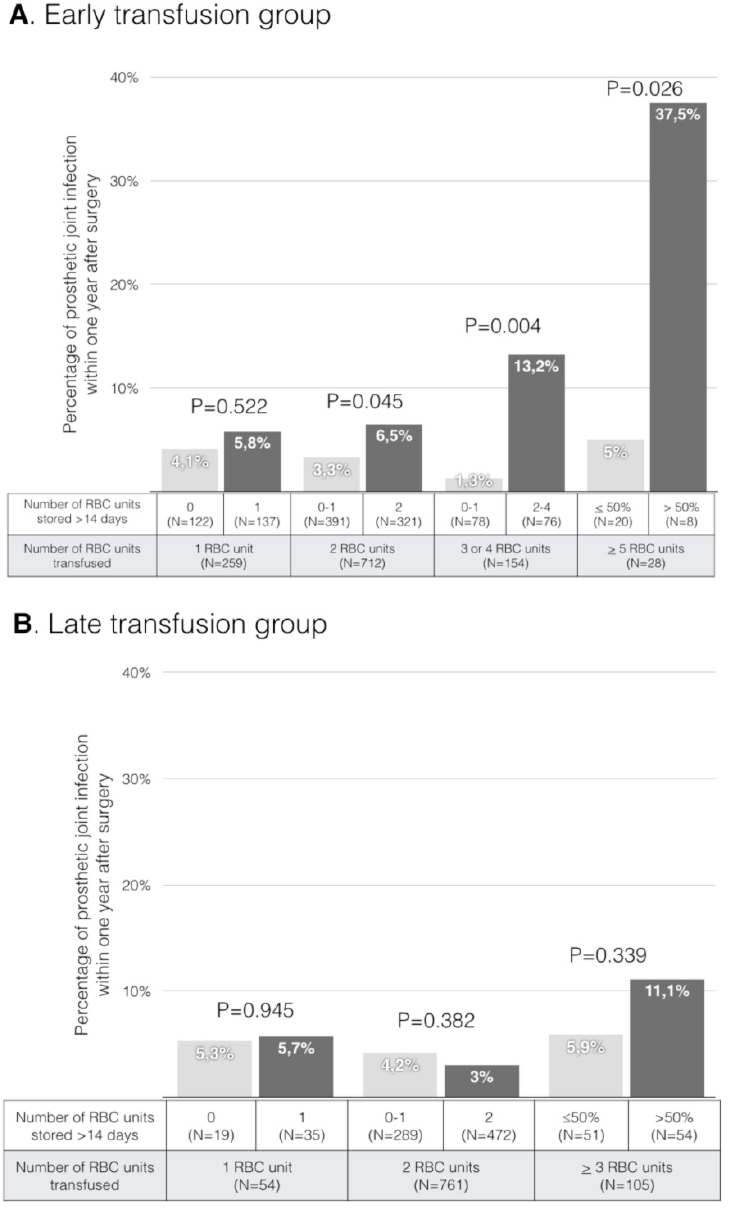
Figure 2. Rate of prosthetic joint infection within the first 365 days after joint arthroplasty according to the number of red blood cell (RBC) units transfused and the proportion of such units stored >14 days. (A) Patients transfused during surgery or within the first 6 hours after surgery; (B) patients transfused only later than 6 hours after surgery and up to the 4th postoperative